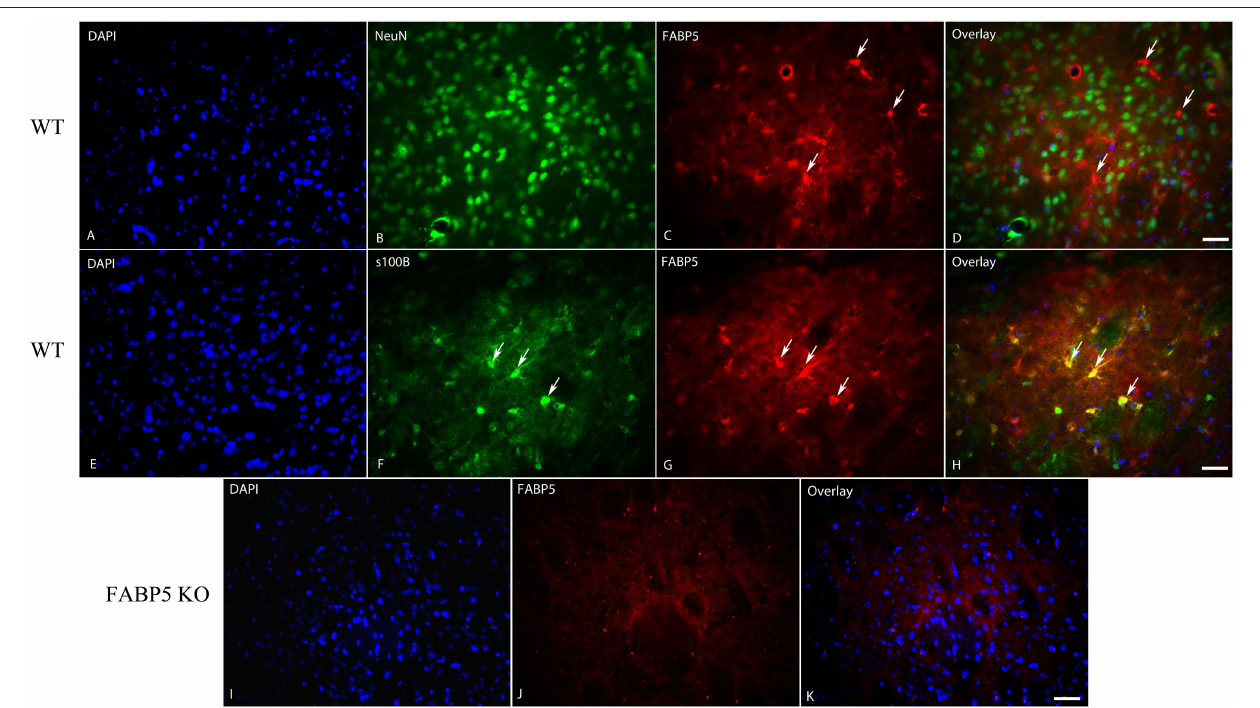
FIGURE 5 | Cellular distribution of FABP5 in the dorsal striatum. Immunolocalization of FABP5 in the striatum of WT mice. Staining for DAPI (A) , the neuronal marker NeuN (B) , FABP5 (C) , and overlay (D) . Note the minimal colocalization of FABP5 in NeuN labeled neurons (arrows). Staining for DAPI (E) , the astrocyte marker S100 β (F) , FABP5 (G) , and overlay (H) . Note that there is robust colocalization between FABP5 and S100 β (arrows), indicating that FABP5 is expressed in astrocytes. Immunostaining was conducted on striatal sections from three WT mice and representative images are shown. (I–K) The lack of FABP5 immunoreactivity in the striatum of FABP5 KO mice. Scale bar = 20 µ